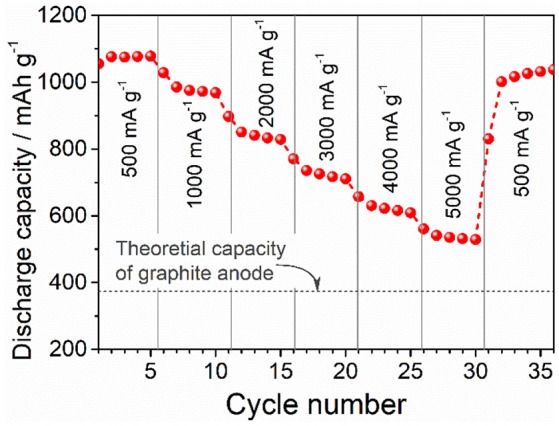
Rate performance of the ZnFe2O4/α-Fe2O3 nanocomposites electrode at various current densities after 250 cycles at a constant density of 500 mA g−1.